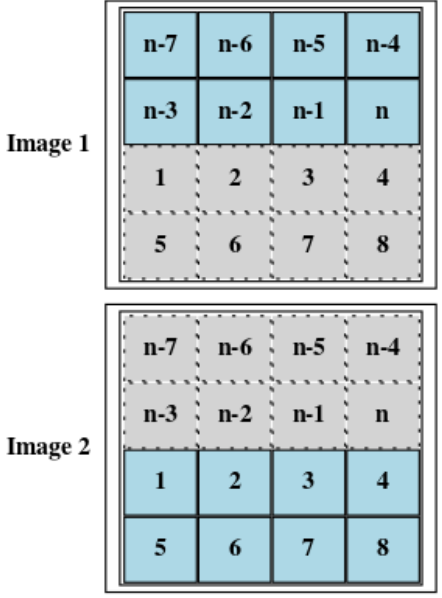
Figure 5. Halo regions to deal with trilinear